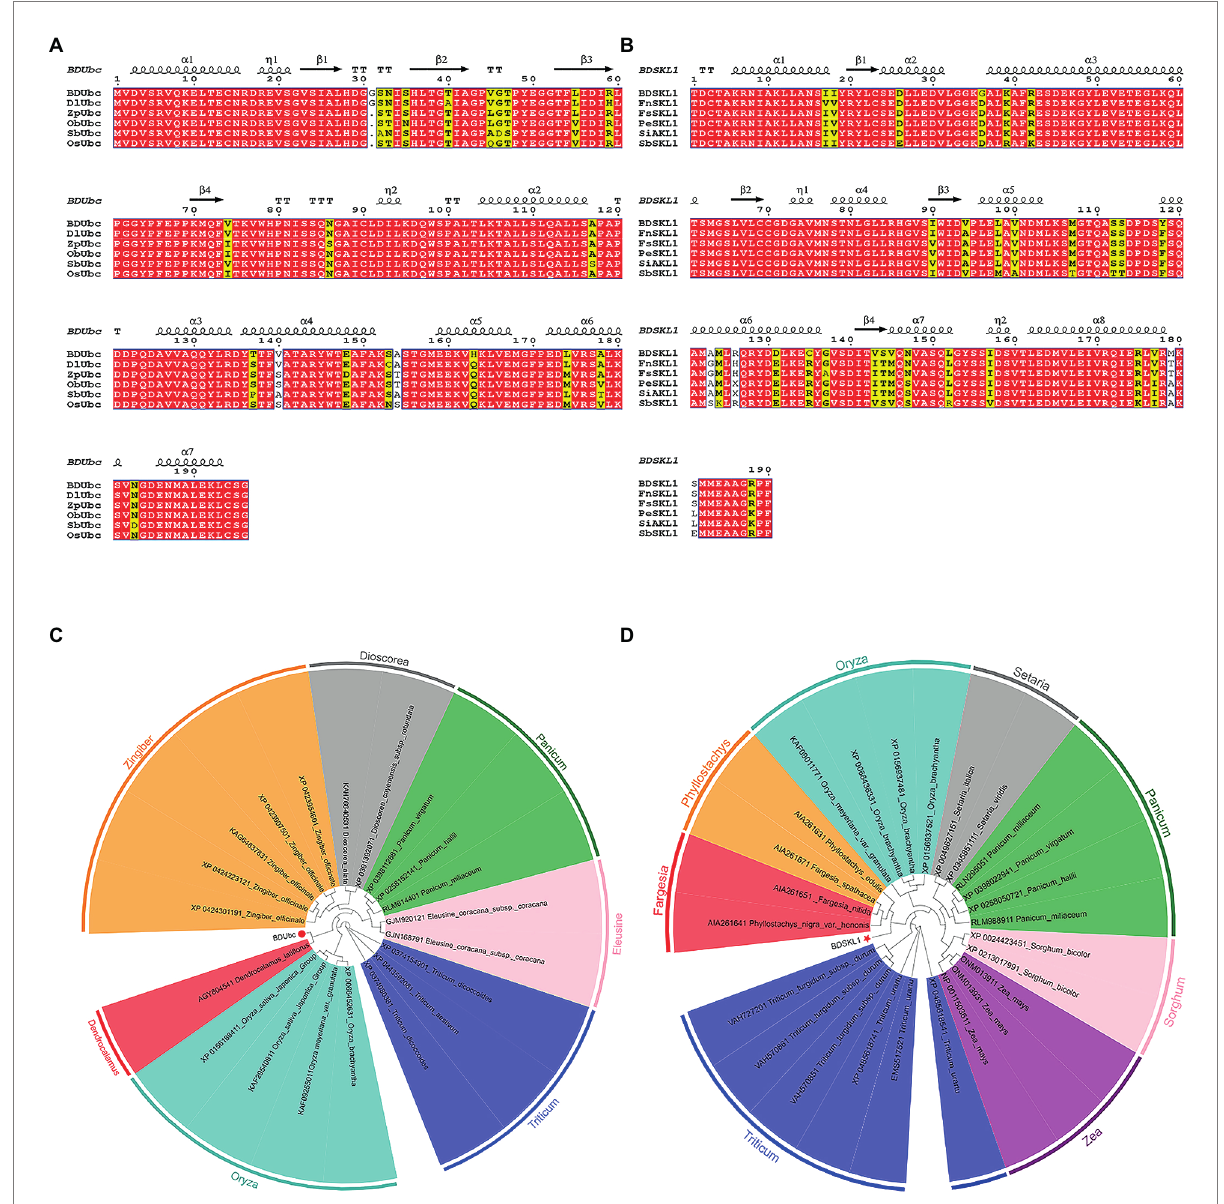
FIGURE 6 Multiple alignment of proteins and target gene phylogenetic tree based on neighbor-joining algorithm. (A) Multiple alignment of the obtained BDUbc protein with BDUbc proteins from other plants; (B) Multiple alignment of the obtained BDSKL1 protein with BDSKL1 proteins from other plants. Completely identical amino acid sequences are indicated using white words and red backgrounds; highly conserved amino acid sequences are represented by black words and yellow backgrounds; non-conserved amino acid sequences are represented by gray words and white backgrounds. α -Helices are displayed as large squiggles and η -helices as small squiggles; strict β -turns are shown as TT letters and β -strands as arrows. Strictly conserved amino acid residues are shown as ★ . (C) BDUbc phylogenetic tree; (D) BDSKL1 phylogenetic tree. The numbers above/ below the nodes indicated bootstrap